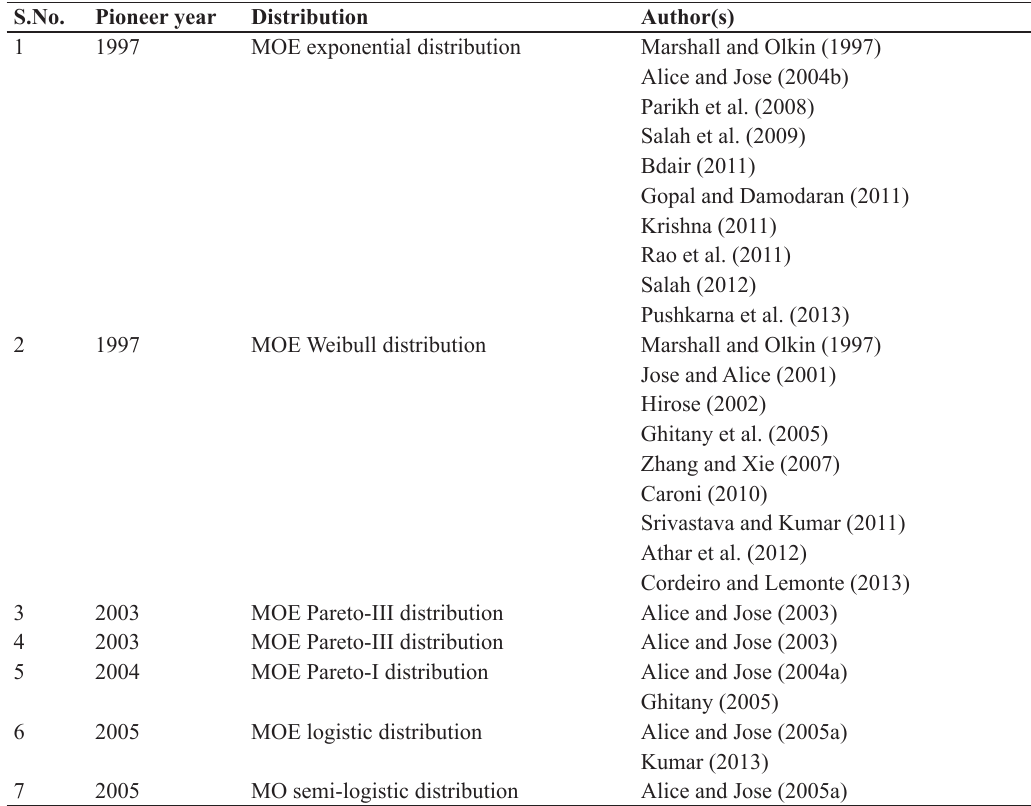
Contributed work on the MOE family of